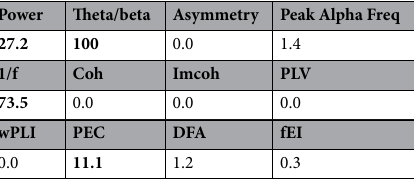
Table 1. Percentage of significant correlations with age. Numbers in bold indicate more than 5% of the features were significantly correlated with age after FDR correction.